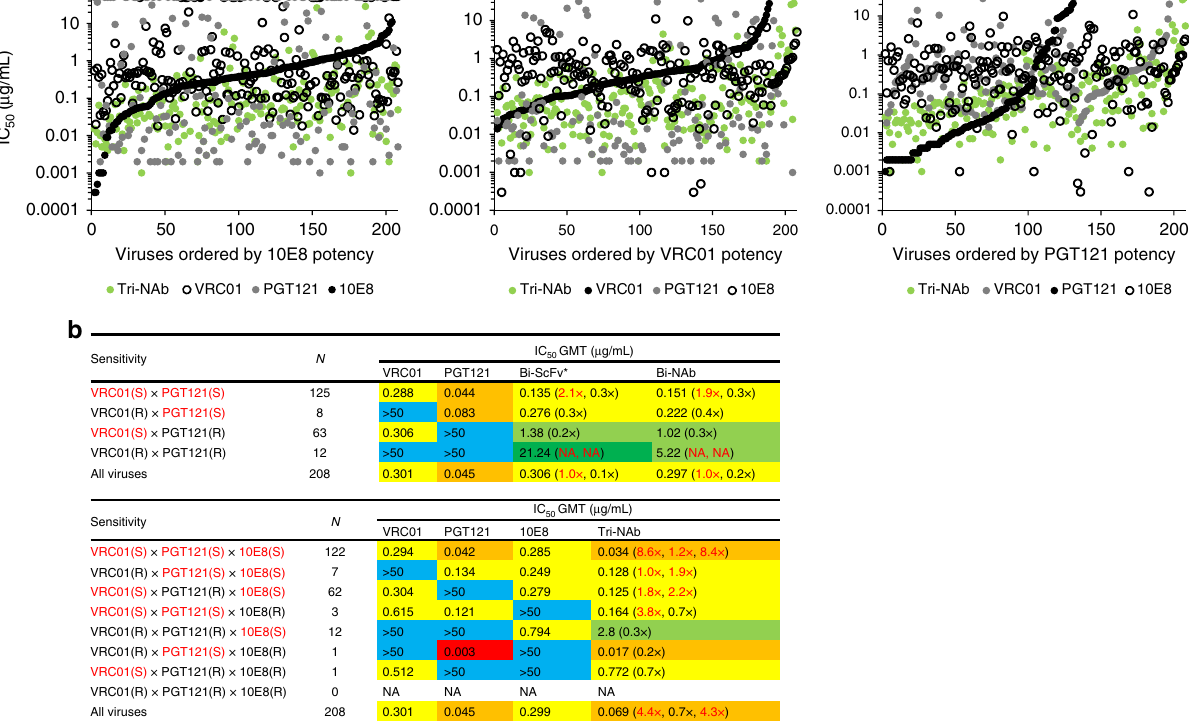
Fig. 7 Analysis of multispeci fi c antibody neutralization breadth and potency. a Comparison of Tri-NAb potency to parental IgGs potencies. Each dot on the graph represents a virus plotted in decreasing order of sensitivity to the reference parental IgG (black). The potency of the Tri-NAb (green), the second parental IgG (gray), and the third parental IgG (open circle) against the same virus is overlaid with data points below the parental IgG indicating increased potency. b Neutralization potency (IC 50 geometric mean values, GMT) of Bi-NAb (upper panel) and Tri-NAb (lower panel) compared to the parental antibodies. Viruses were grouped by parental antibody sensitivity, with S indicating sensitive and R, resistant. N, the number of viruses under each sensitivity group. IC 50 GMT titer fold change re fl ecting potency compared to the respective antibodies is indicated in the parentheses next to the multispecifc antibody potency. Fold changes in red indicating improved potency. ( † indicates that the IC 50 was adjusted by a factor of 3 to account for the molarity difference between the lower molecular weight Bi-ScFv and the IgG, Bi-NAb or